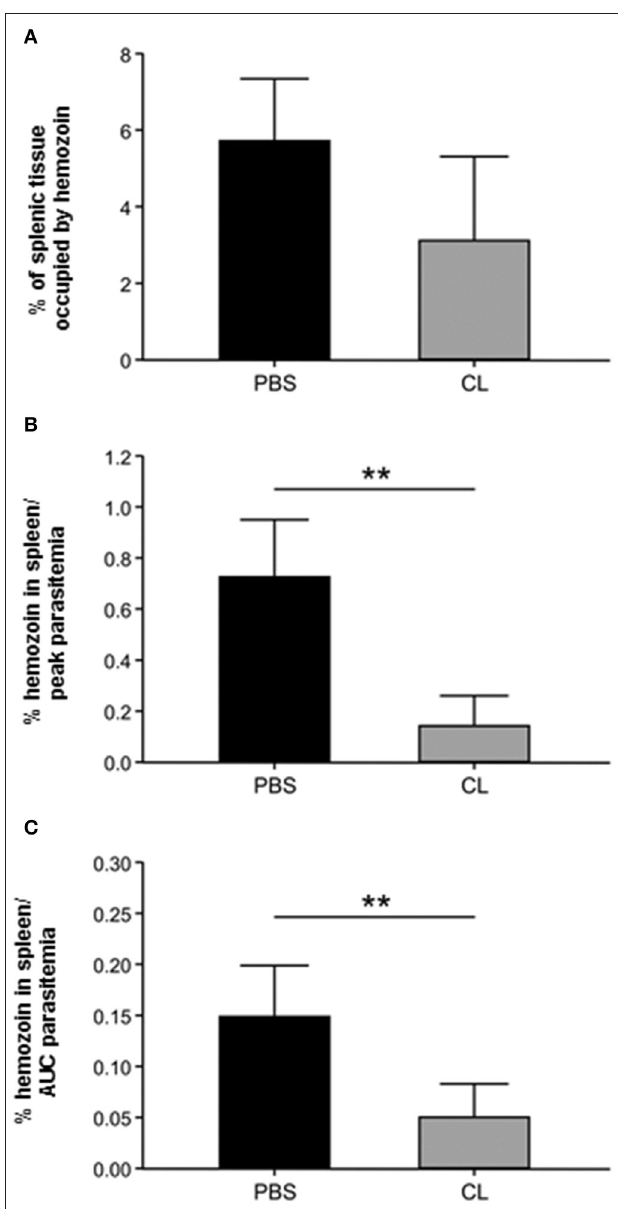
FIGURE 10 | Estimation of the effect of CL treatment on splenic macrophage population through hemozoin quantification. (A) Percentage of the splenic tissue occupied by hemozoin in PBS-treated and CL-treated infected animals. (B,C) Amount of splenic hemozoin adjusted by parasitemia in PBS-treated and CL-treated infected animals. The percentage of splenic tissue occupied by hemozoin (as in A ) was divided by the peak parasitemia (B) or by the area under the curve (AUC) of parasitemia (C) of each animal. ** P <